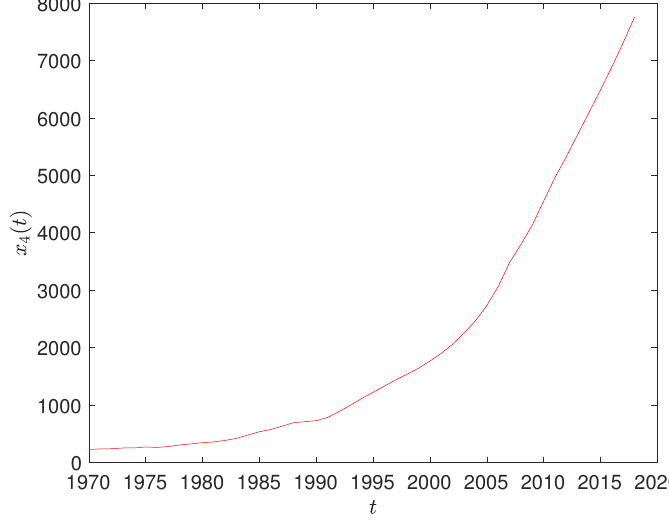
Figure 1. The gross domestic product (GDP) of China, x 4 ( t ) , during